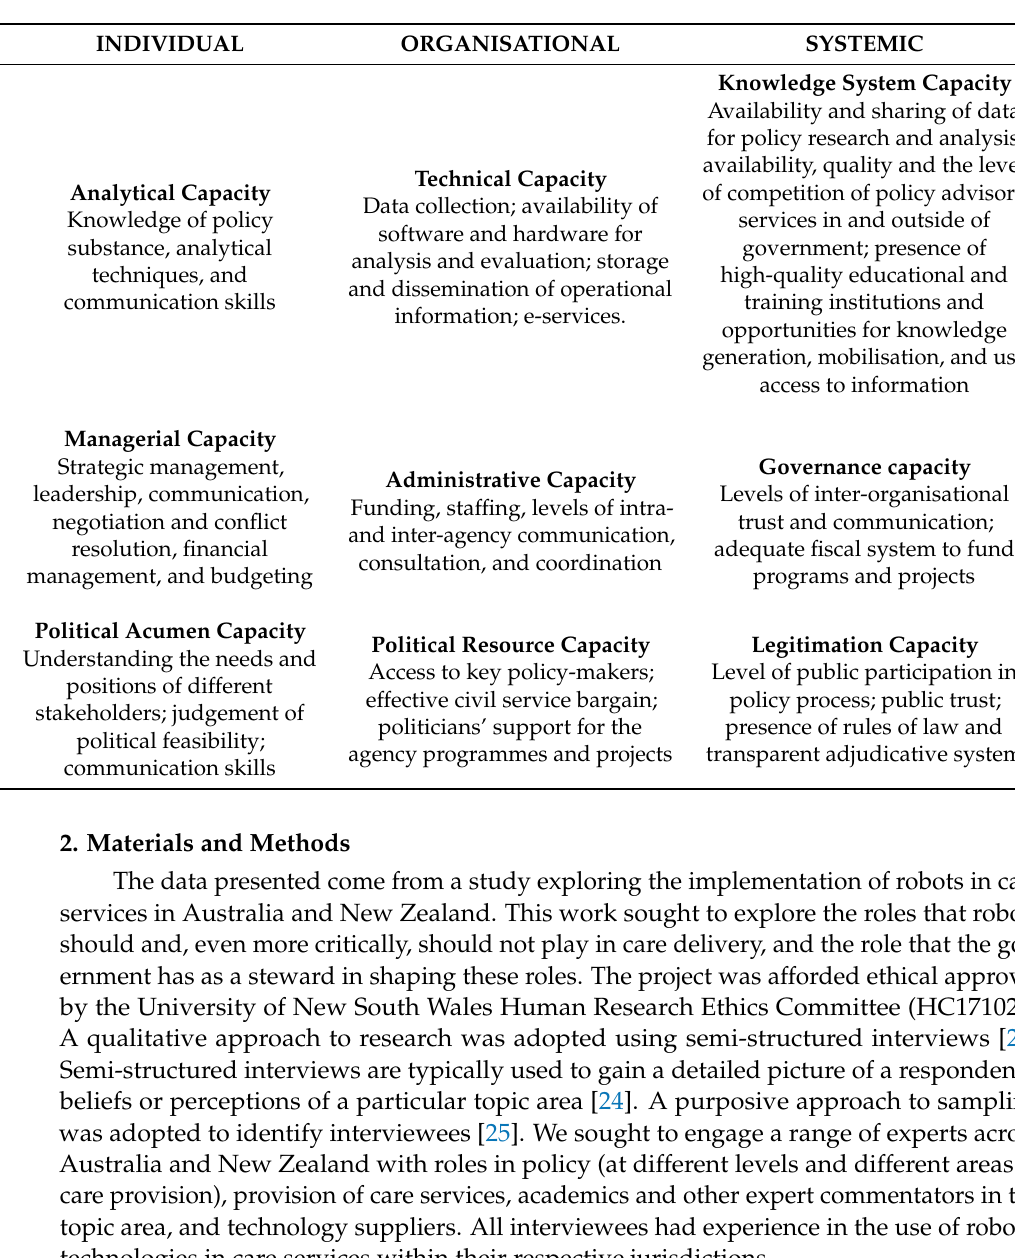
Table 1. Wellstead and Steadman’s framework of policy capacity